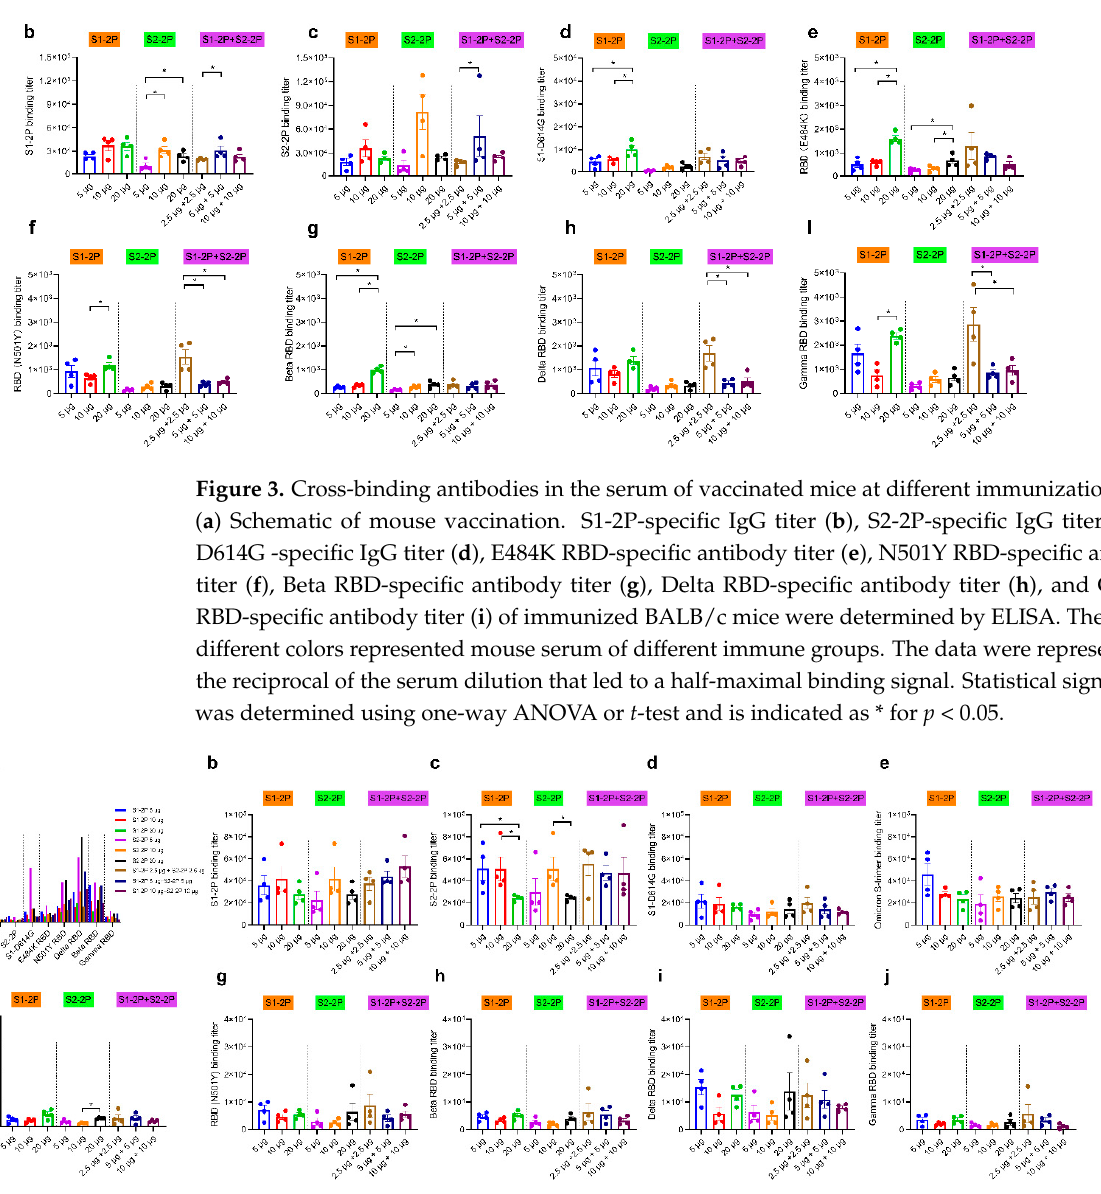
Figure 4. Elevated cross-binding antibody responses after the third immunization. ( a ) The increased fold of serum antibody titer after the third immunization compared with that after the second immunization. S1-2P-specific IgG titer ( b ), S2-2P-specific IgG titer ( c ), S1-D614G -specific IgG titer ( d ), Omicron S trimer-specific IgG titer ( e ), E484K RBD-specific antibody titer ( f ), N501Y RBD-specific antibody titer ( g ), Beta RBD-specific antibody titer ( h ), Delta RBD-specific antibody titer ( i ), and Gamma RBD-specific antibody titer ( j ) of immunized BALB/c mice were determined by ELISA. The dots of different colors represented mouse serum of different immune groups. The data were represented as the reciprocal of the serum dilution that led to a half-maximal binding signal. Statistical significance was determined using one-way ANOVA or t -test and is indicated as * for p <